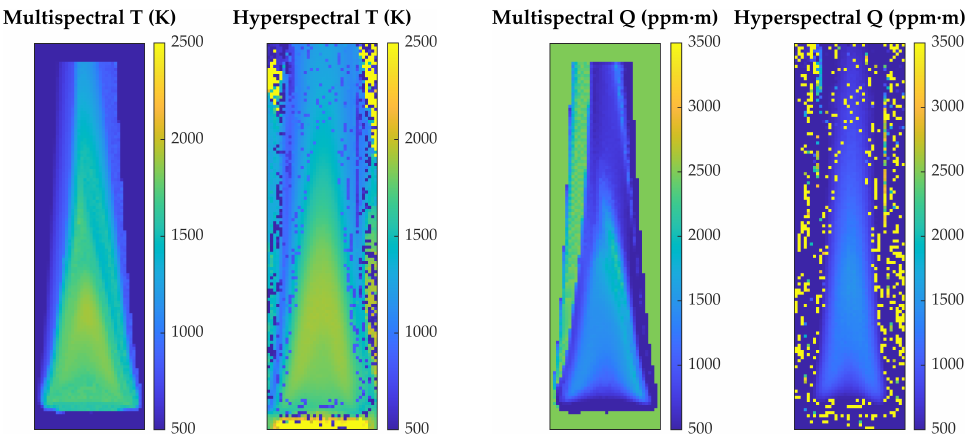
Figure 10. Maps of temperature and CO 2 column density for a Bunsen flame, obtained with the multispectral method and with the hyperspectral